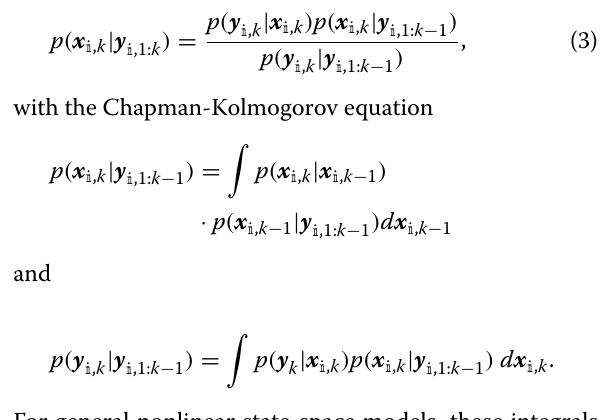
Multiple particle filtering aims to mitigate the curse of dimensionality by employing a bank of parallel PFs. An outline of the MPF procedure is given in Algorithm 1. The differences with respect to the particle representations are illustrated in Fig. 1. Most importantly, in classical PFs